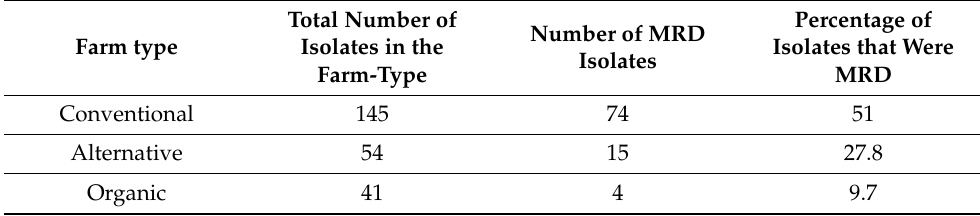
Table 2. Origin of genotypic MRD isolates ( n = 93) carrying more than two AMR genes against different antimicrobial